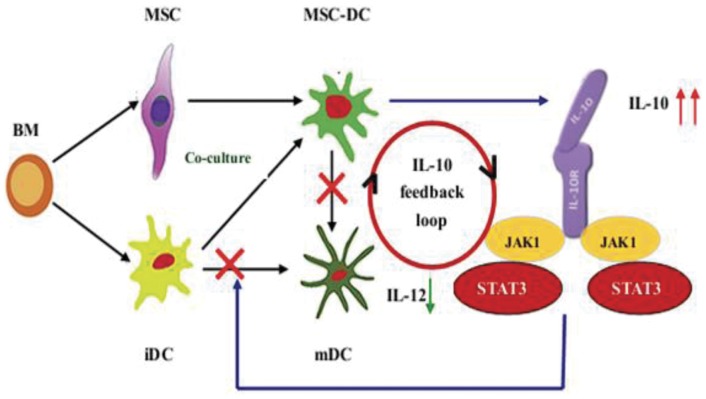
Newly proposed IL-10 feedback loop.The figure illustrates the interplay between IL-10 and the JAK1/STAT3 signaling pathway involved in mechanism inhibition of DCs maturation by MSCs. The MSCs facilitate the combination of the cytokine IL-10 with its IL-10 receptor. This complex activates the JAK1/STAT3 signaling pathway that suppresses the DCs maturation. This inhibition of maturation causes a decrease in the expression of IL-10. Thus, the levels of the cytokine IL-10 command this positive feedback loop.